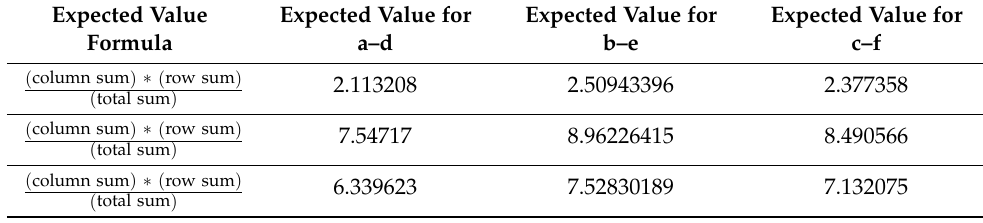
Table 7. Chi-square Expected